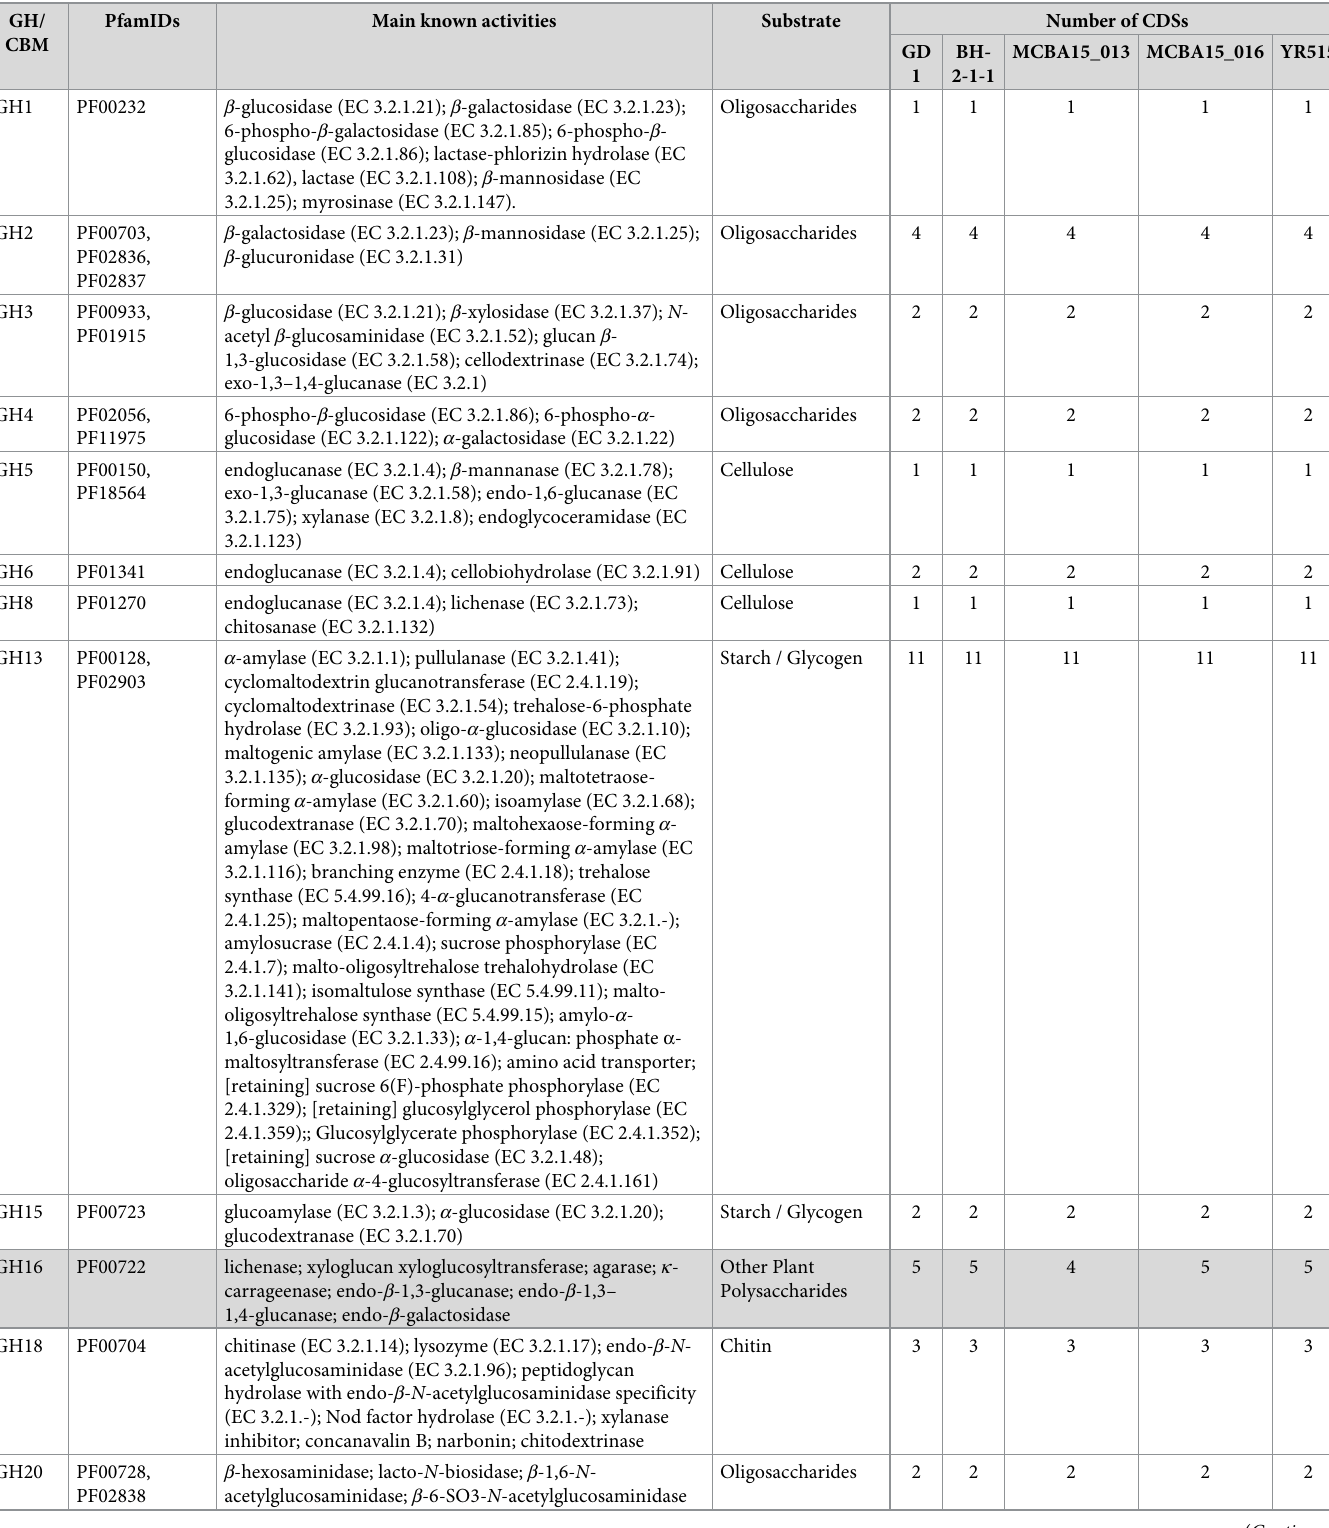
Table 4. Detected glycoside hydrolases (GH) and carbohydrate-binding modules (CBM) within related Curtobacterium spp. strains. GH/ CBM